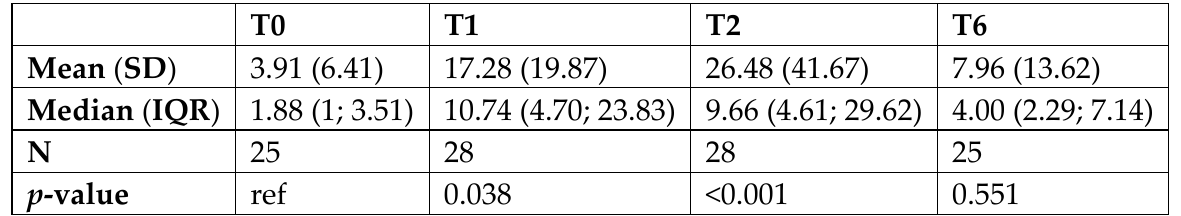
Figure 1. The overall rate of change over time for CD4+ T cell response to Spike megapools (MPS). The values were significant at T1 ( p = 0.038) and at T2 ( p < 0.001) compared to T0 with a decrease at T6 ( p not significant). The data are expressed as Stimulation Index (SI), mean (standard deviation, SD) and median (interquartile range, IQR). The bolded line indicates the overall rate of change over time among the entire cohort of health workers